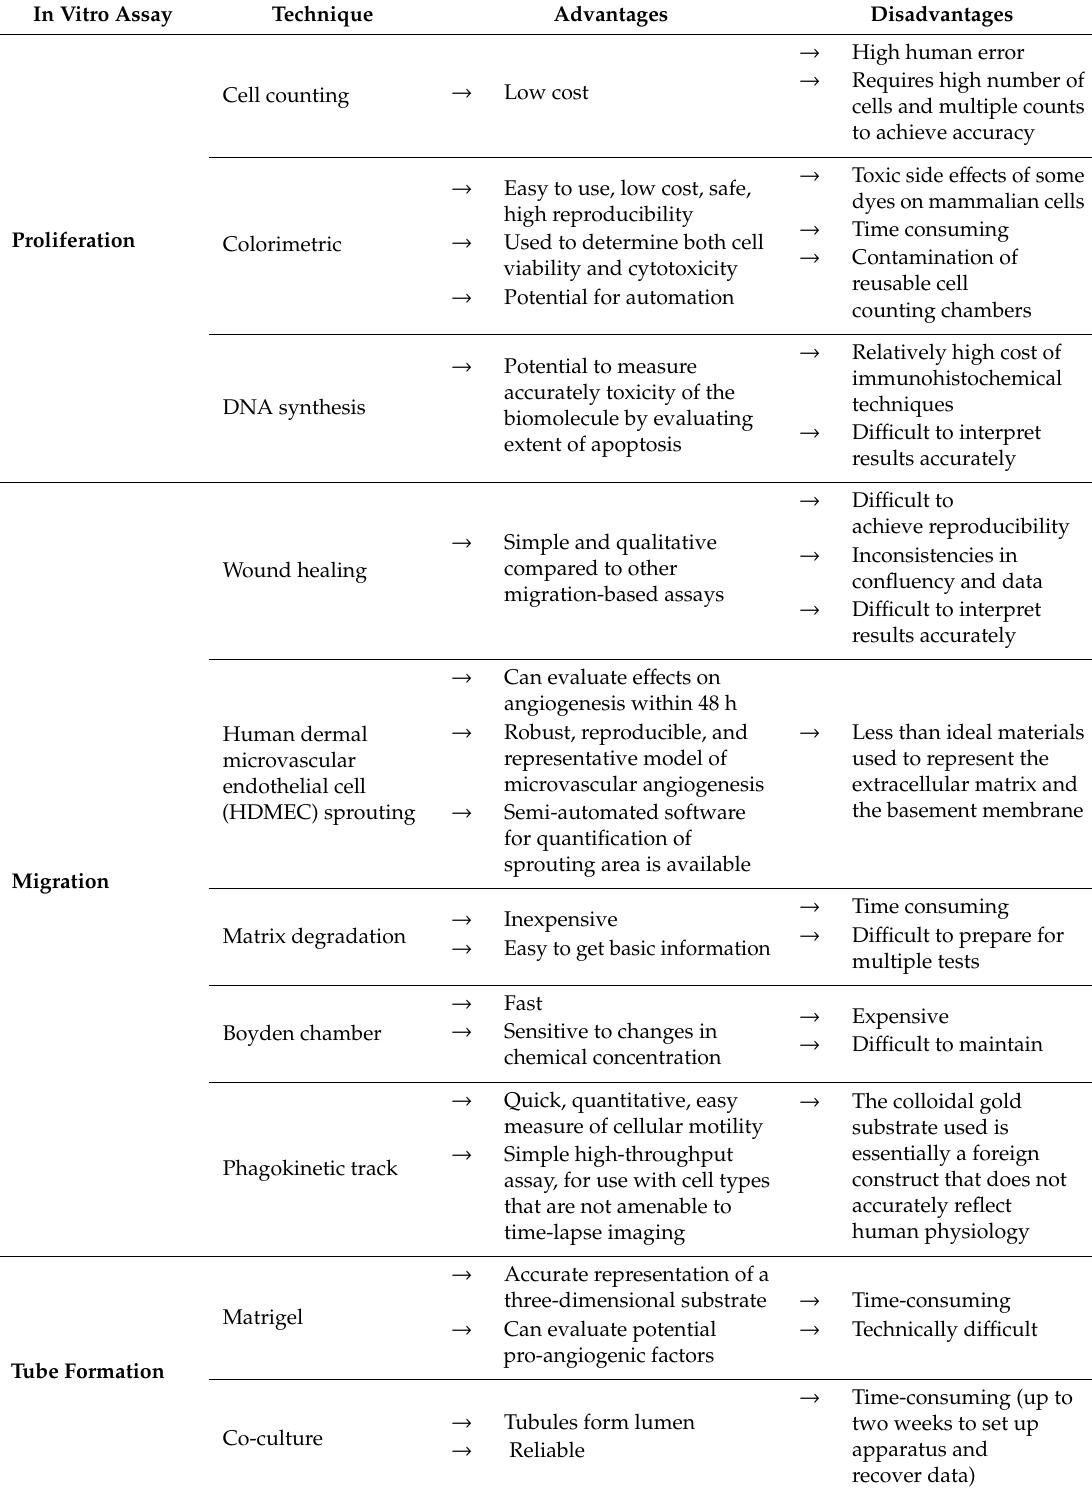
Table 1. Angiogenesis assays: the most commonly used methods to evaluate angiogenesis modulators. In Vitro